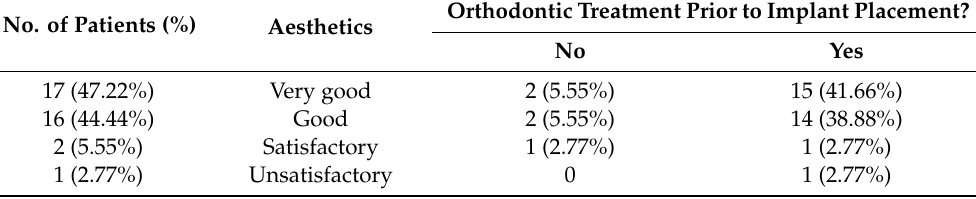
Table 3. The relationship between the aesthetic treatment outcomes and the orthodontic treatment prior to implant placement.